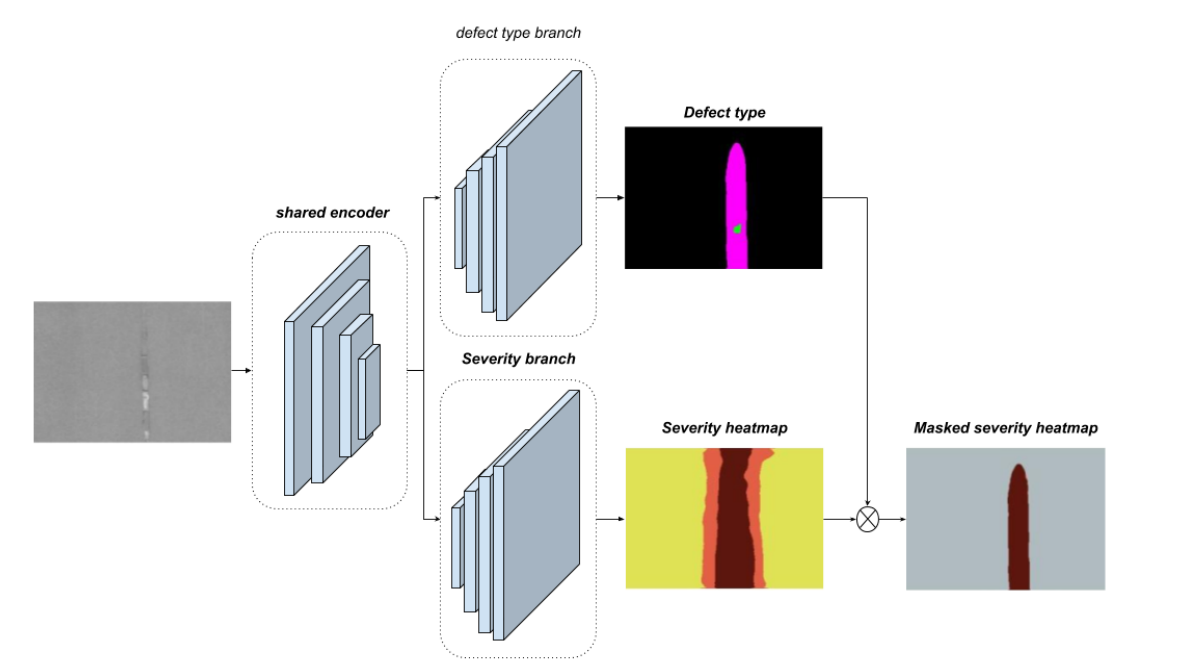
Figure 6. An overview of our multi-branch network. We expanded the U-Net architecture by adding an additional decoder branch. Each branch learns a specific segmentation task. The first branch (defect type branch) learns the segmentation of defect types. The second branch (severity branch) learns to generate a severity heatmap. The defect type mask generated by the first branch is then used to mask out the severity heatmap to generate the defect severity